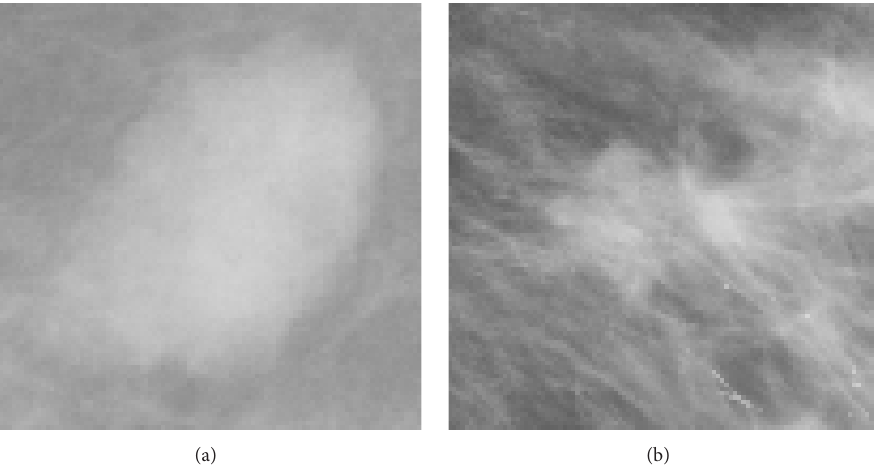
Figure 1: ROIs extracted from the mini-MIAS breast cancer database. A ROI containing (a) a benign mass and (b) a malignant mass.